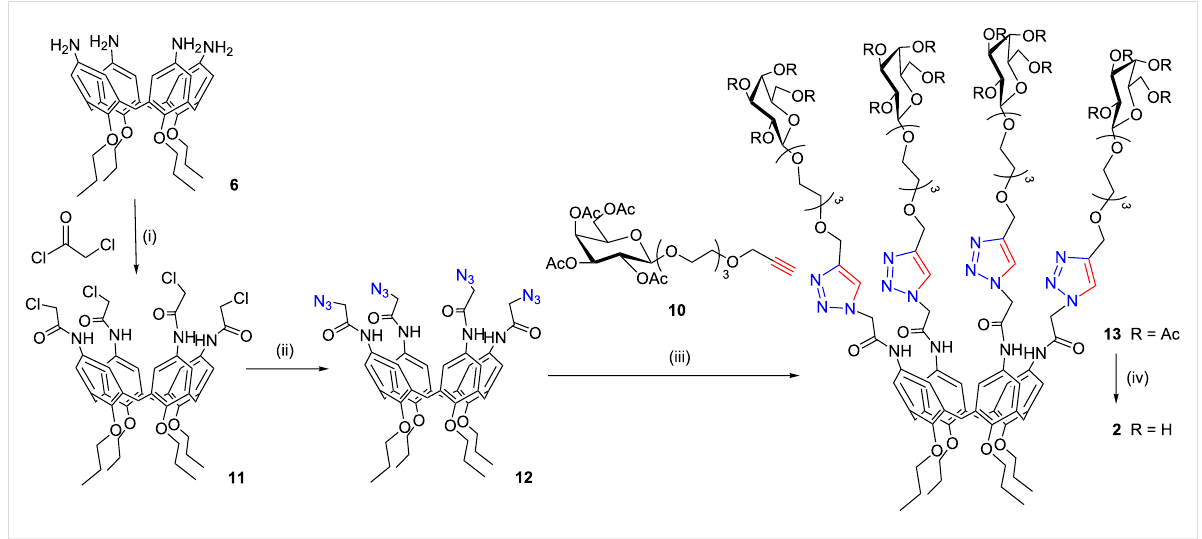
Scheme 2: Synthesis of the cone galactosylcalix[4]arenes 2 . Reaction conditions: (i) DIPEA, CH 2 Cl 2 , rt, 6 h, 55%; (ii) NaN 3 , CH 3 OH/DMF, reflux, 1 h, 75%; (iii) CuSO 4 ·5H 2 O, Na-ascorbate, DMF/H 2 O, μ W (150 W), 80 °C, 20 min, 81%; (iv) CH 3 ONa, CH 3 OH, rt, 1 h – IR120/H + , rt, 30 min, quantitative.